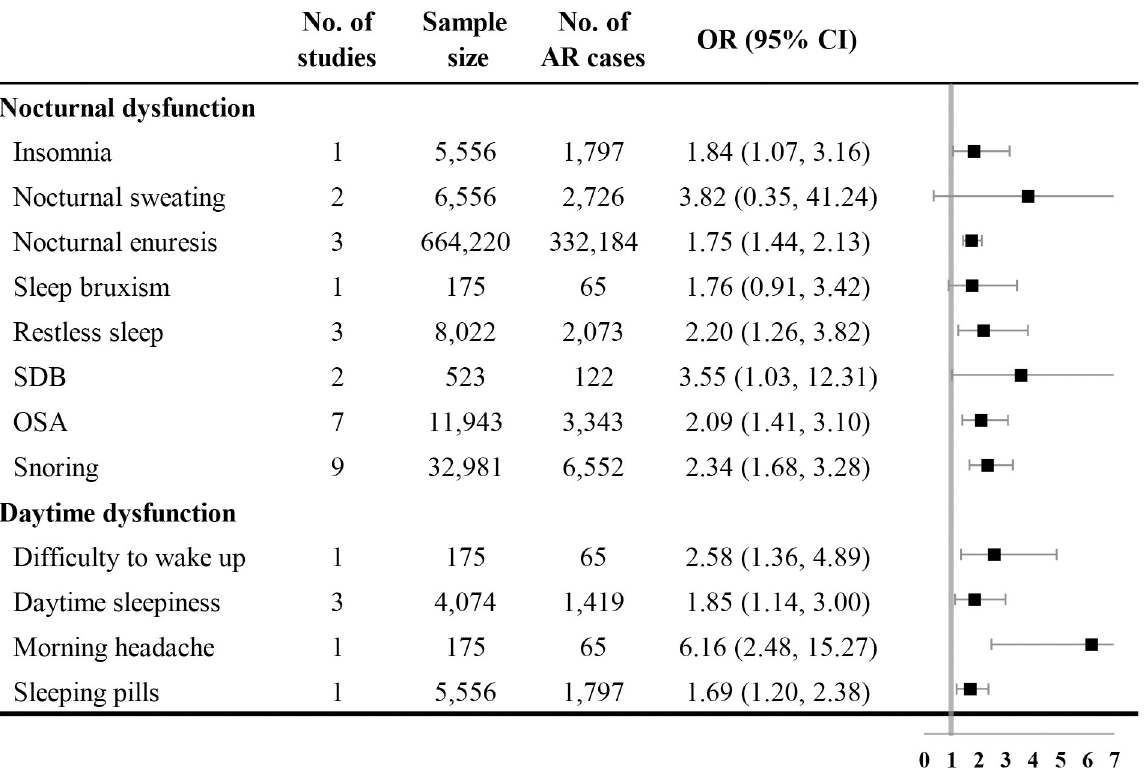
Fig 4. Forest plot for adjusted associations between AR and sleep outcomes. AR: allergic rhinitis; CI: confidence interval; OR: odds ratio; OSA: obstructive sleep apnea; SDB: sleep-disordered breathing.